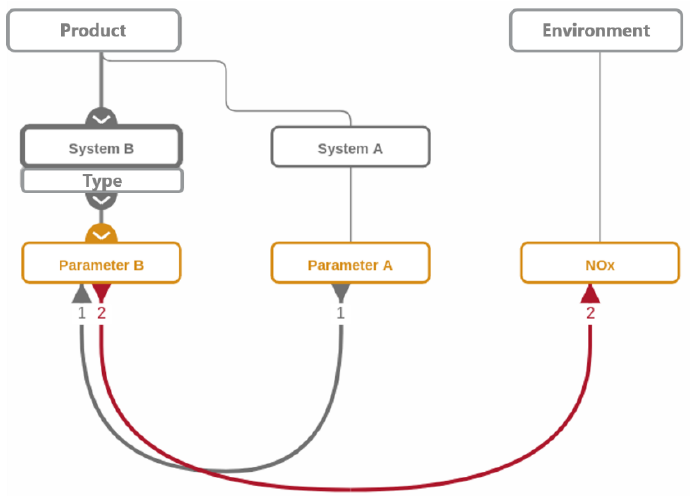
Figure 4. Example of a simplified cause-and-effect chain.